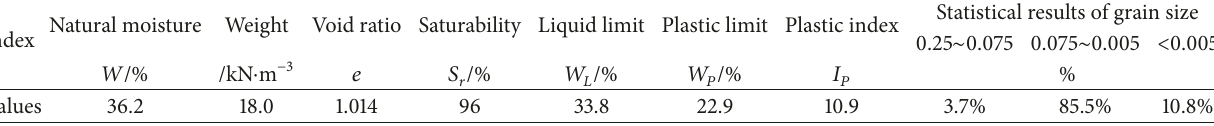
Table 1: The physical and mechanical indices of soft soil.